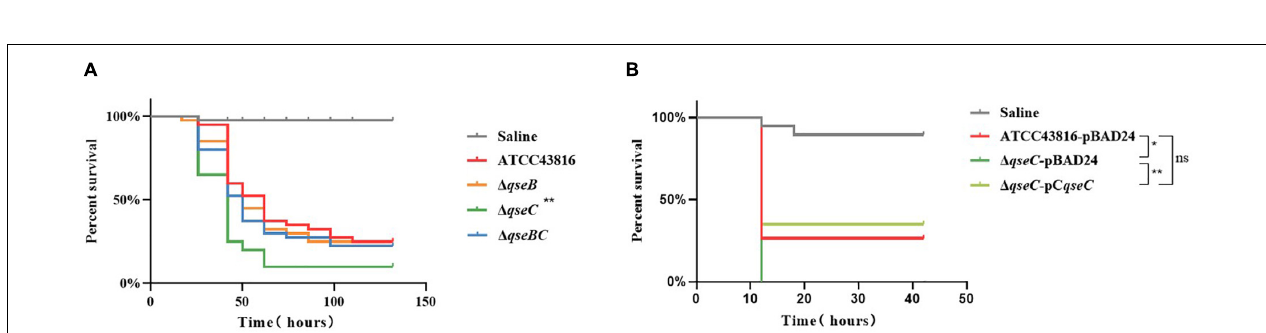
FIGURE 4 | (A) Larvae survival of ATCC43816, (cid:49) qseB , (cid:49) qseC and (cid:49) qseBC . Galleria mellonella were injected with 105 CFU wild-type and mutants (40 larvae per group). The survival of G. mellonella infected with (cid:49) qseC was significantly lower compared with that of the wild-type group ( P = 0.0012, Log-rank test). (B) Larvae survival of ATCC43816-pBAD24, (cid:49) qseC -pBAD24 and the complement strain (cid:49) qseC -pC qseC . The survival of G. mellonella infected with (cid:49) qseC -pC qseC was significantly higher than that of (cid:49) qseC -pBAD24 ( P = 0.0040, Log-rank test).